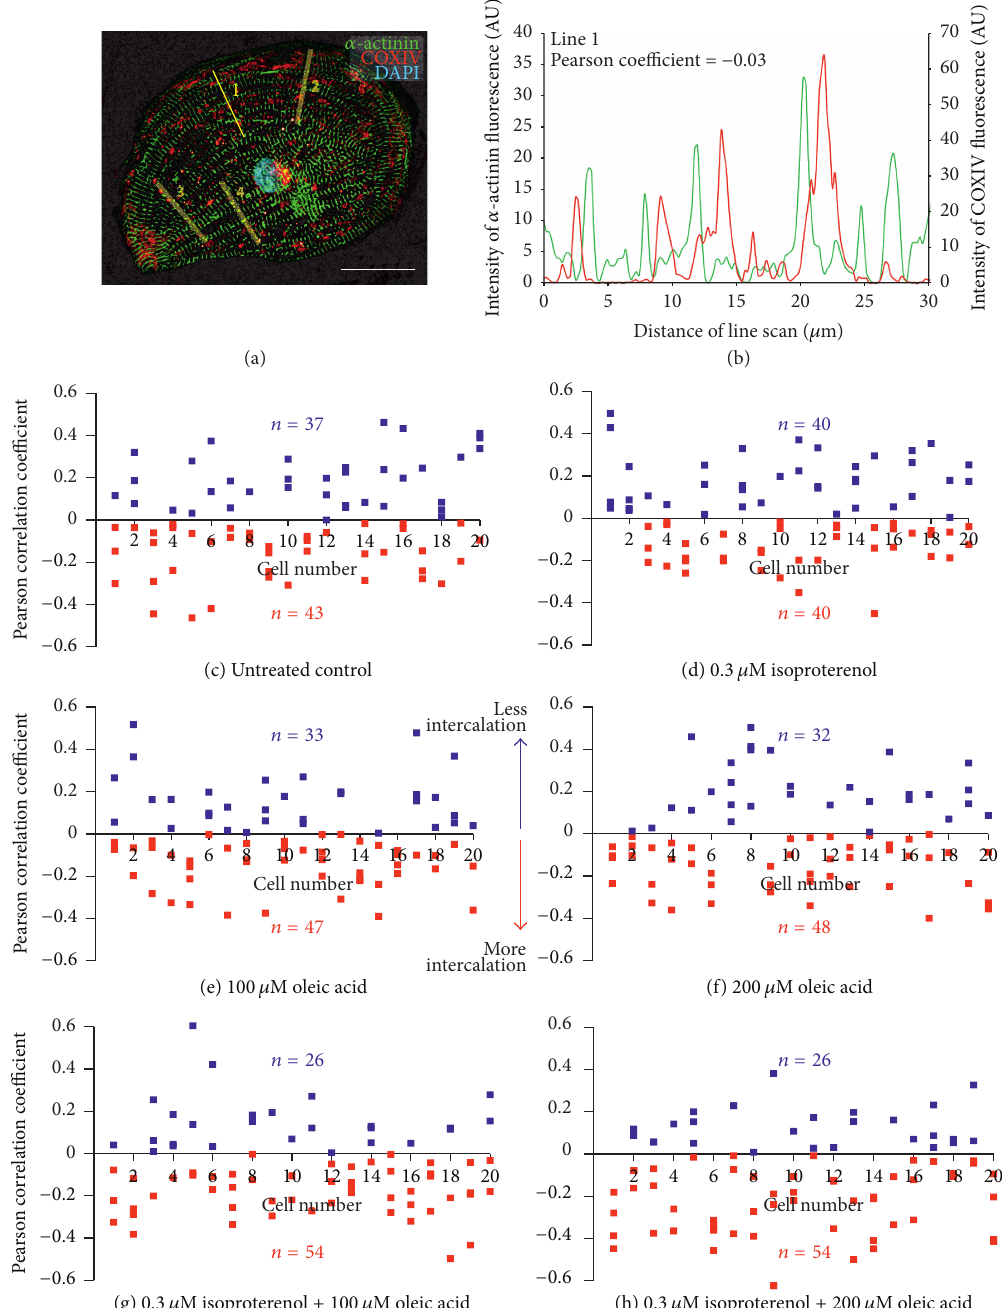
Figure 4: Effect of isoproterenol and oleic acid on the intercalation of the mitochondria between the myofibrils. (a) Representative example of an hESC-vCM that had been immunolabeled with antibodies to 𝛼 -actinin and COX IV and costained with DAPI, to label the myofibrils, mitochondria, and nucleus, respectively. Four line scan analyses were then performed per cell, such that the lines were placed perpendicular to the orientation of the myofibrils and were kept away from the nucleus. Scale bar is 30 𝜇 m. (b) Representative line graph to show the intensity of fluorescence of 𝛼 -actinin (green) and COX IV (red) labeling along line 1 from panel A. The Pearson correlation coefficient (PCC) was calculated to be − 0.03. (c–h) Series of scatter graphs to show the PCC determined for each of 4 lines in 𝑛 = 20 cells in (c) untreated controls and (d–h) following treatment with (d) 0.3 𝜇 M isoproterenol, (e) 100 𝜇 M oleic acid, (f) 200 𝜇 M oleic acid, (g) 0.3 𝜇 M isoproterenol plus 100 𝜇 M oleic acid, or (h) 0.3 𝜇 M isoproterenol plus 200 𝜇 M oleic acid. Numbers in blue and red indicate line scans exhibiting positive and negative PCC values, respectively, the latter indicating a higher level of intercalation between the COX IV labeled mitochondria and the 𝛼 -actinin-labeled